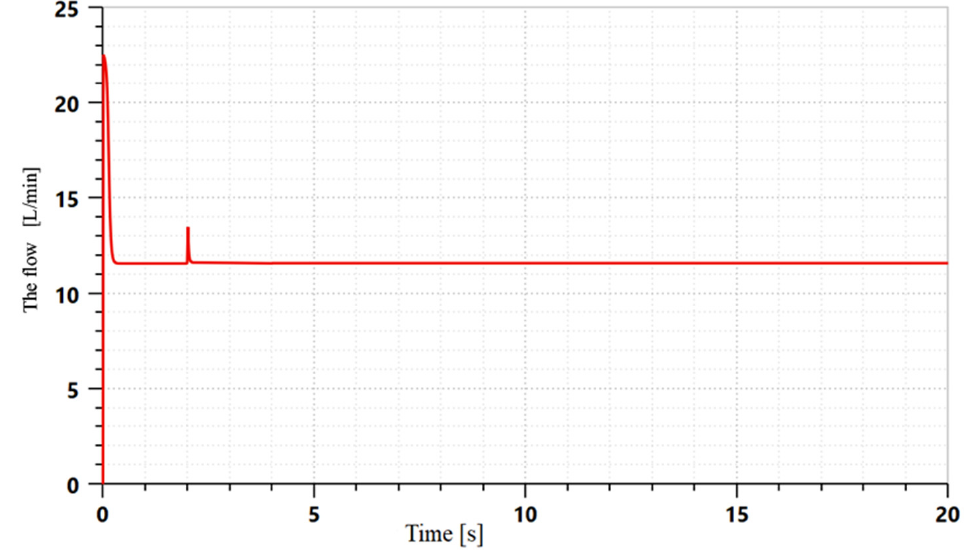
Figure 5. Influence of different pressure changes on flow rate.